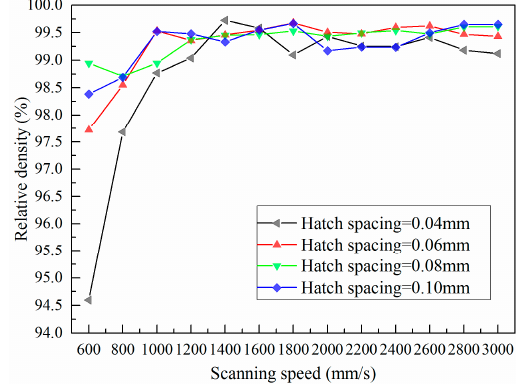
Figure 5. Relative density of SLMed struts.